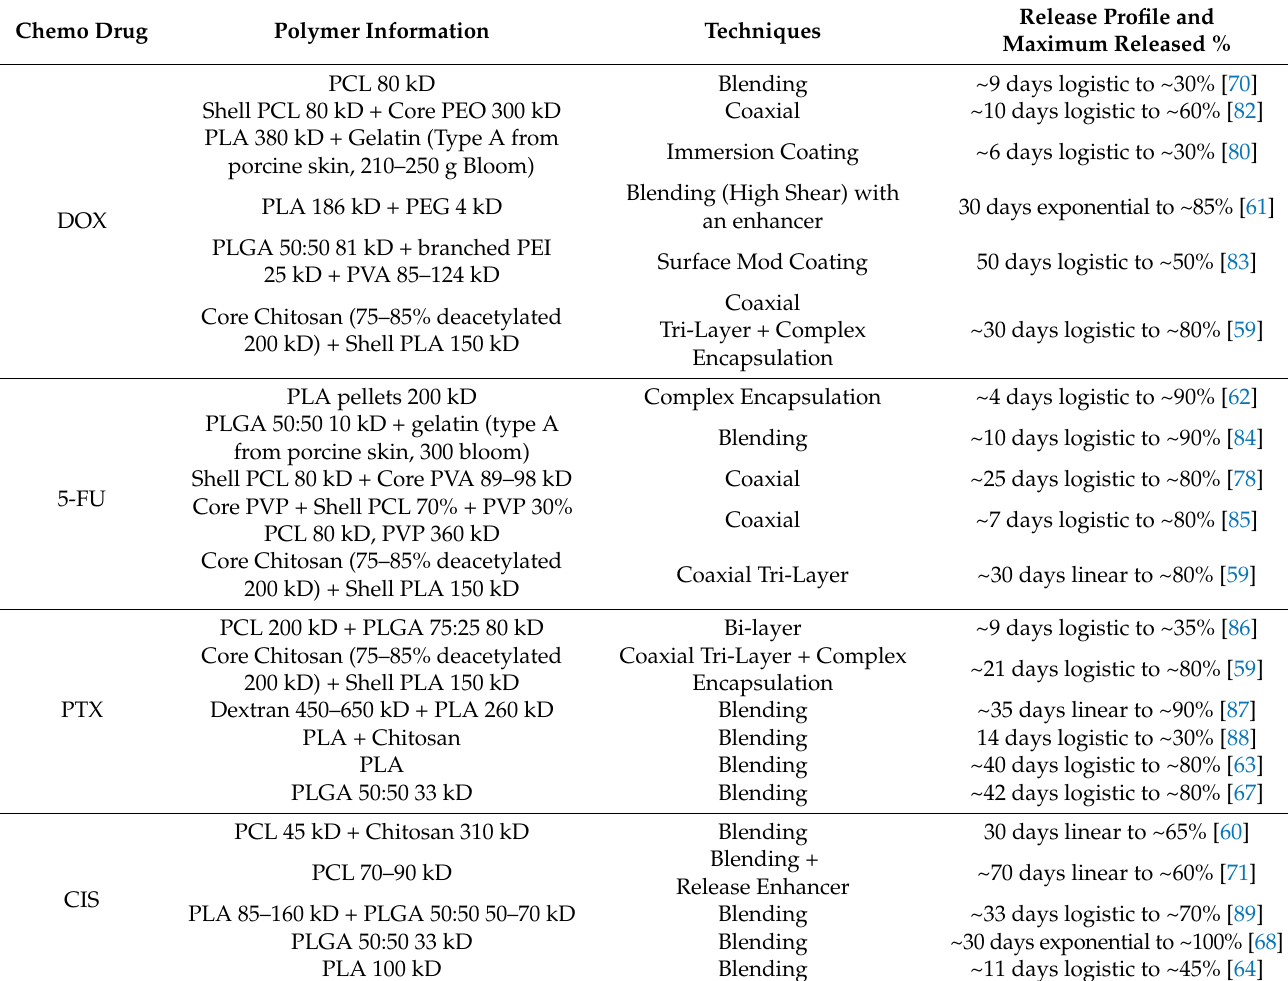
Table 2. Polymer information, electrospun techniques, and release profiles of electrospun chemother- apy drug membranes with controlled release